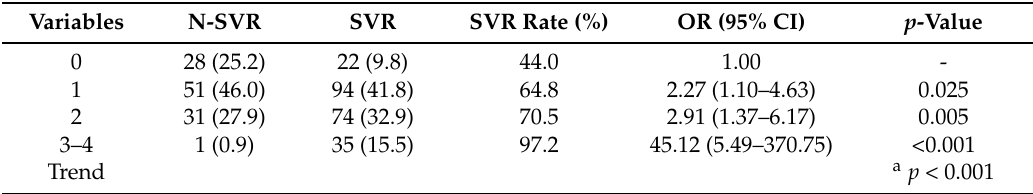
Table 3. Combined effects of rs23544 and rs1063478 with SVR.